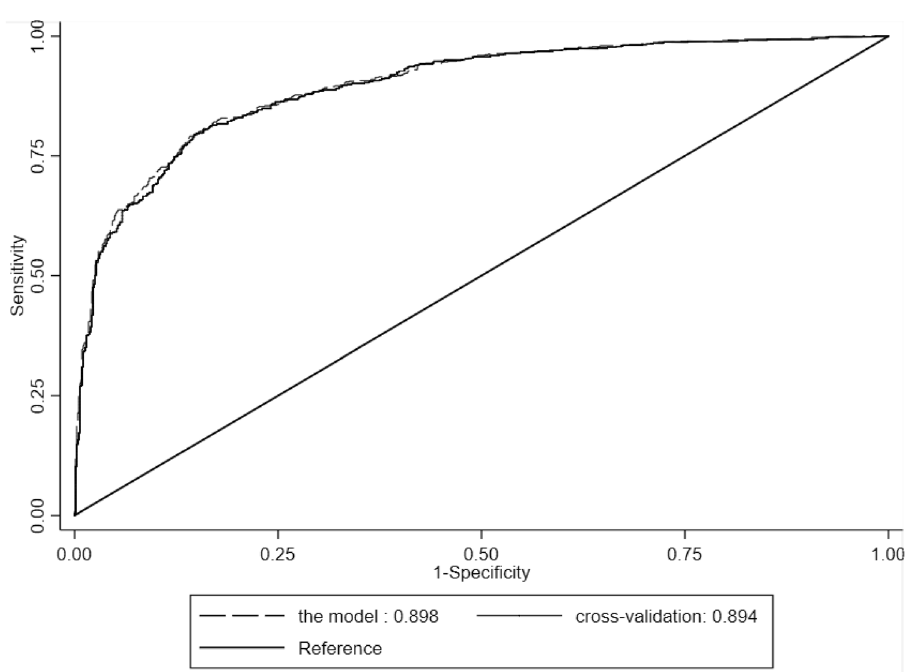
Figure 8. Comparison of the area under the receiver operating characteristic curve (AUROC) values between the mionl-MEWS and cross